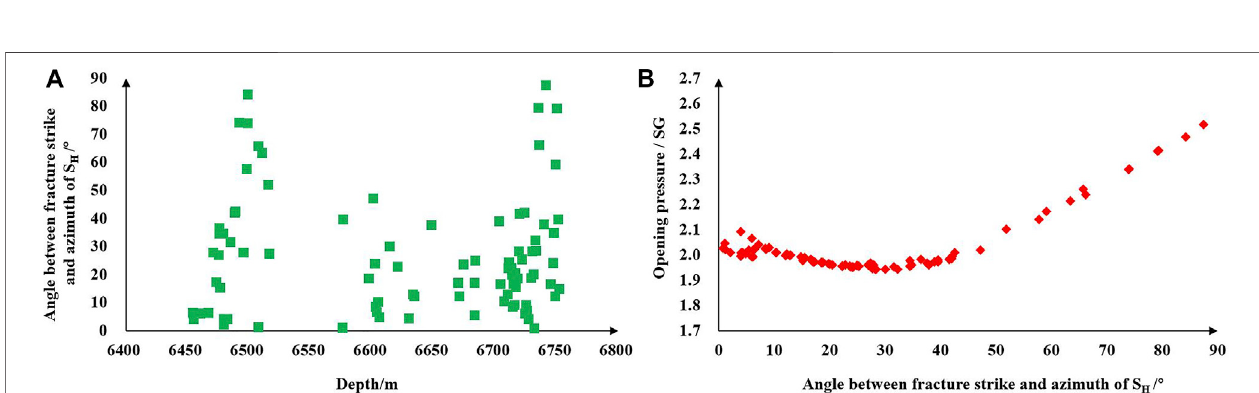
FIGURE8|(A) isthestatisticaldiagramoftheincludedanglebetweenthenaturalfracturestrikeandthecurrentmaximumprincipalstressazimuthofthestratumat differentdepthsofwellks504.Itcanbeseenfromthe fi gurethattheincludedanglebetweenthenaturalfracturestrikeandthecurrentmaximumprincipalstressazimuth of the well iswidely distributed, witha large number of developmentat 0 – 90 ° . (B) isthe opening pressure distribution diagram of natural fractures withdifferent included angles in well ks 504 calculated according to the above opening pressure calculation method. It can be seen from the fi gure that the variation range of fracture opening pressure is 1.94 – 2.52MPa/100 m, among which the opening pressure of natural fractures with an included angle of 28.8 ° is the lowest, which is 1.94MPa/ 100 m (the depth of fracture development formation is 6,733 m, and the opening pressure is 128 MPa), The maximum opening pressure of natural fractures with an included angle of 87.5 ° is 2.52MPa/100 m (the depth of fracture development formation is 6741m, and the opening pressure is 166.6 MPa).